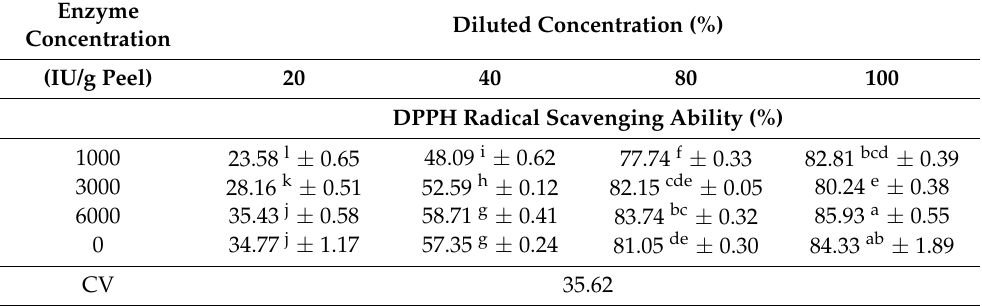
Table 7. DPPH free radical scavenging activity of banana peel.